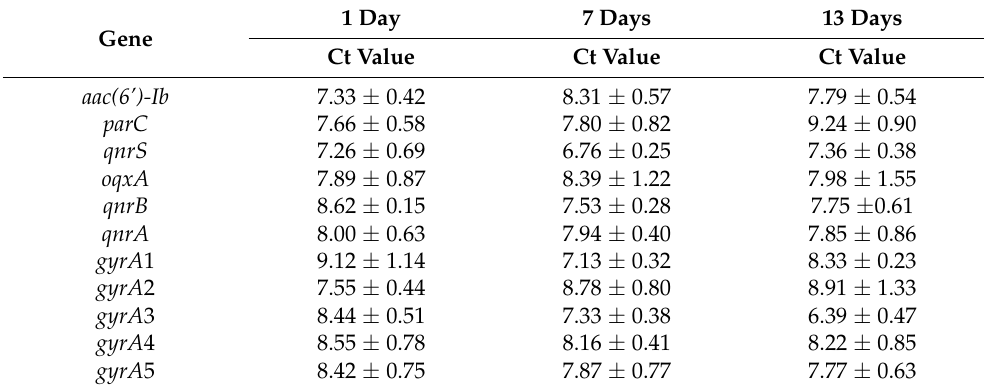
Table 4. Ct values of qPCR for plasmid DNA reference materials stored at 37 ◦ C (Mean ± SD).